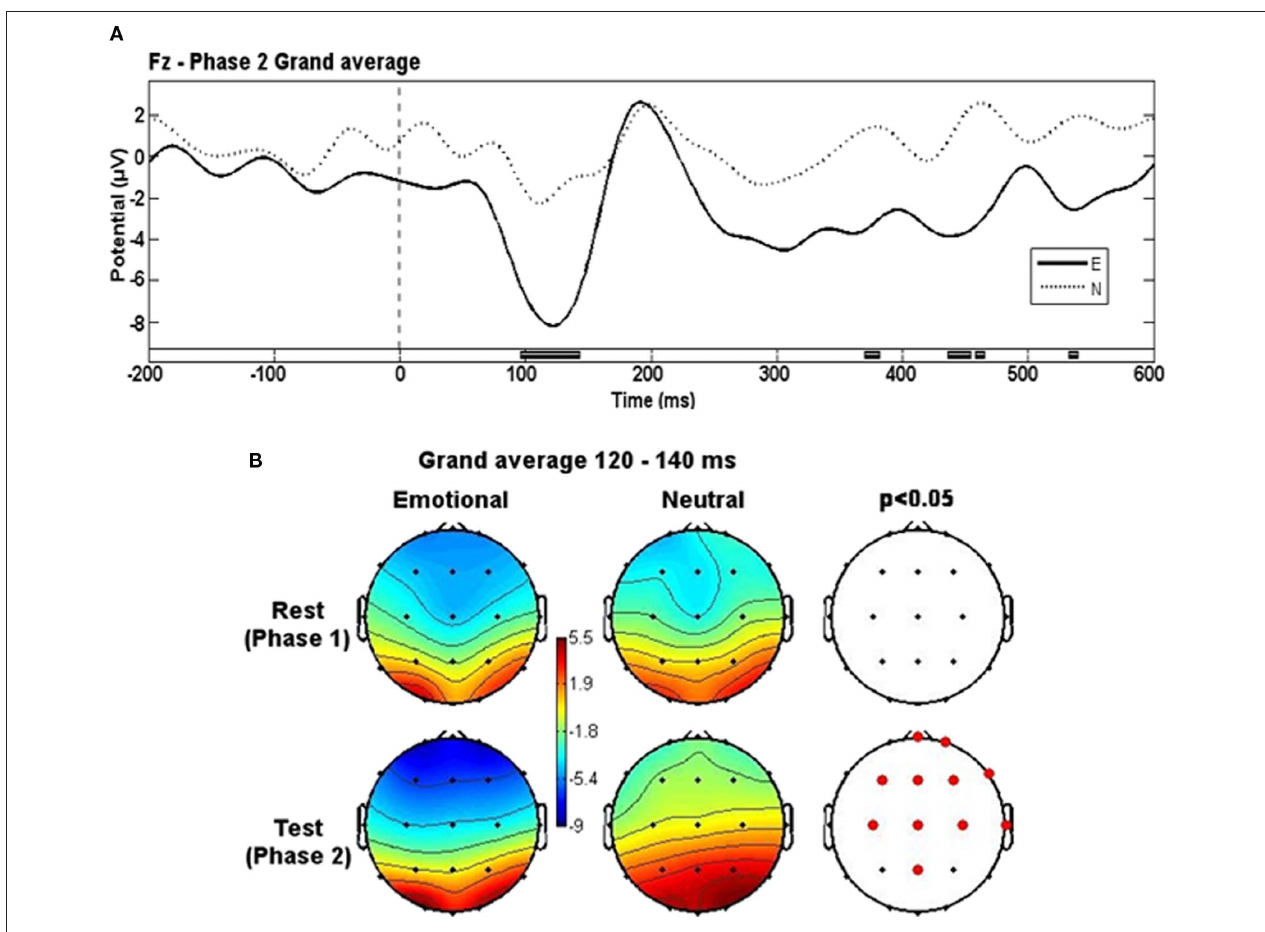
Figure 2 | evoked potentials grand-averages. (A) Phase 2 grand-averages for E and N groups. Black blocks at bottom represent the time intervals where significant differences appeared. Low-pass filter of 20 Hz. ( B) Topographical representation of activity for each group in both phases at the 120–140 ms time window. Red dots represent electrode locations where significant differences appeared.